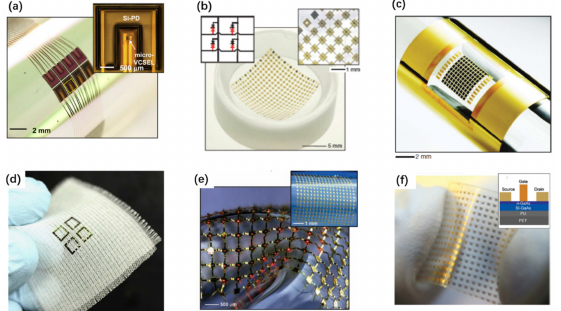
Figure 25. ( a ) A fluorescence sensor on PET wrapped around a cylindrical support interconnected by Cr (15 nm)/Ag (1500 nm)/Au (30 nm). Adapted with permission from [175]. Copyright